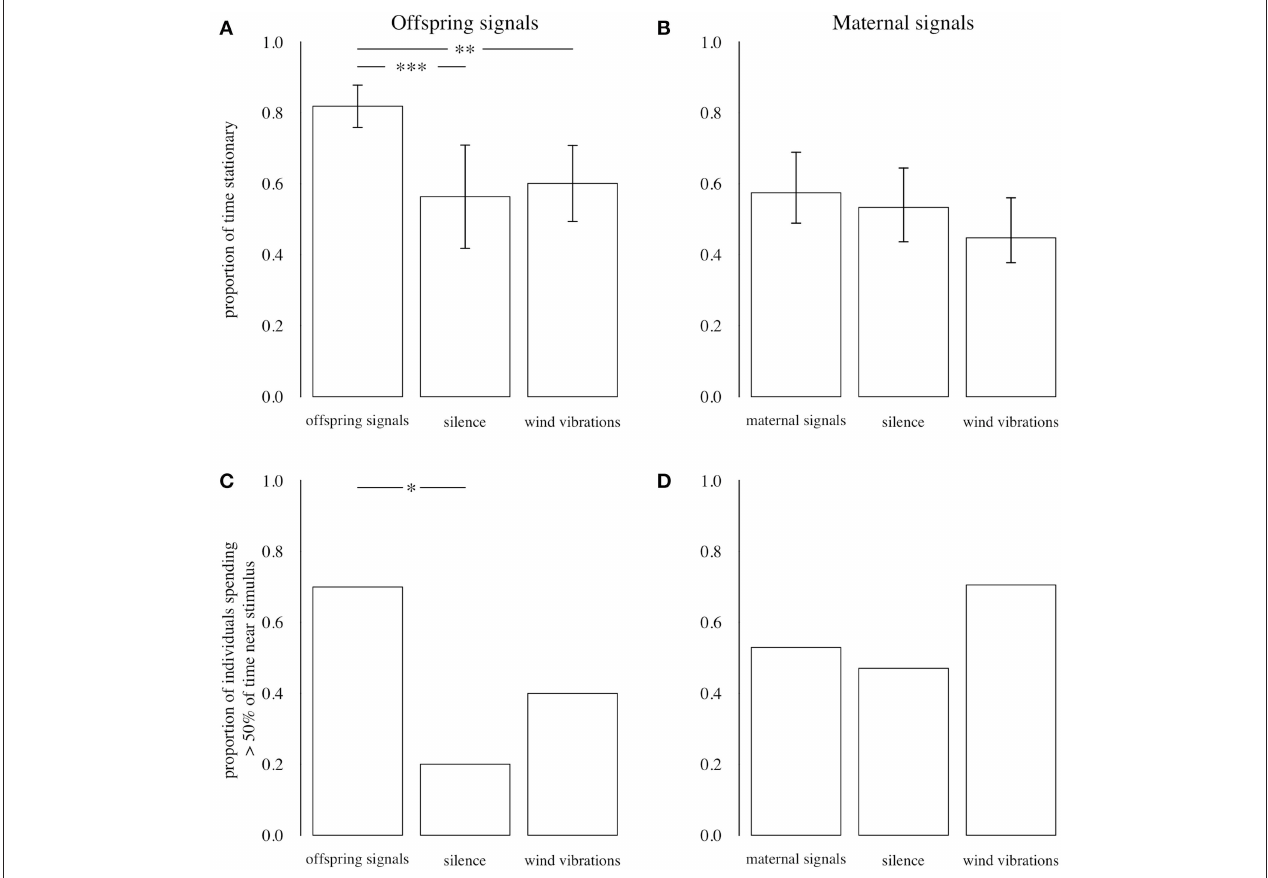
FIGURE 7 | Top : Proportion of time that predators remained stationary during playbacks of offspring (A) and maternal (B) signals, silence, and wind vibrations. Bars show means; error bars are 95% CIs. Bottom : Proportion of individuals who spent > 50% of total time near the vibration stimulus during playbacks of offspring (C) and maternal (D) signals, silence, and wind vibrations. Data from Experiments 4 and 5. * P ≤ 0.05, ** P ≤ 0.01, *** P ≤ 0.001,